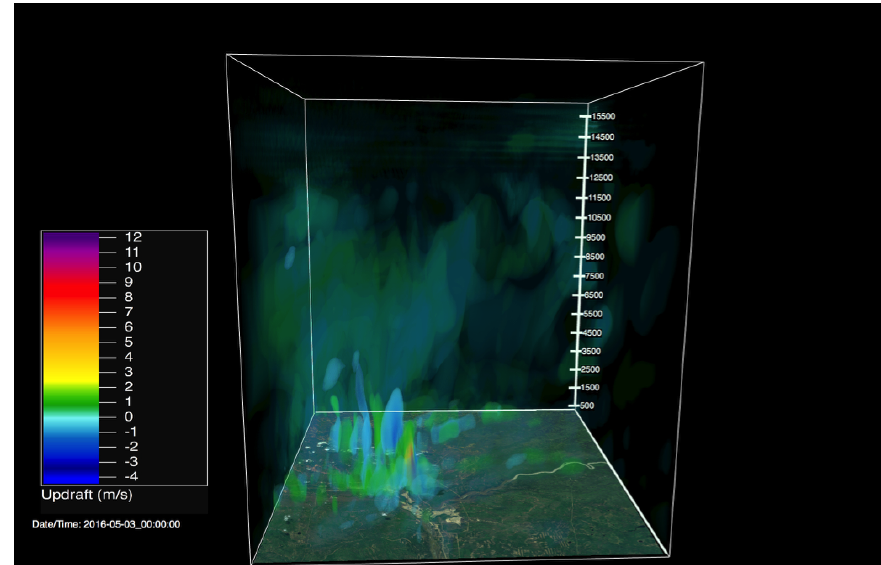
Figure 4. Updrafts and downdrafts at 00 UTC on May 3, 2016. The box is 55 km on each side and is 16 km tall. The blue colors are downdrafts and bright colors are updrafts. The box represents the fire domain and the finest resolution of the model at 200 m. The wind speed color transparency is weighted to present a more transparent area for speeds between − 1 to 1 m/s. Image produced by VAPOR